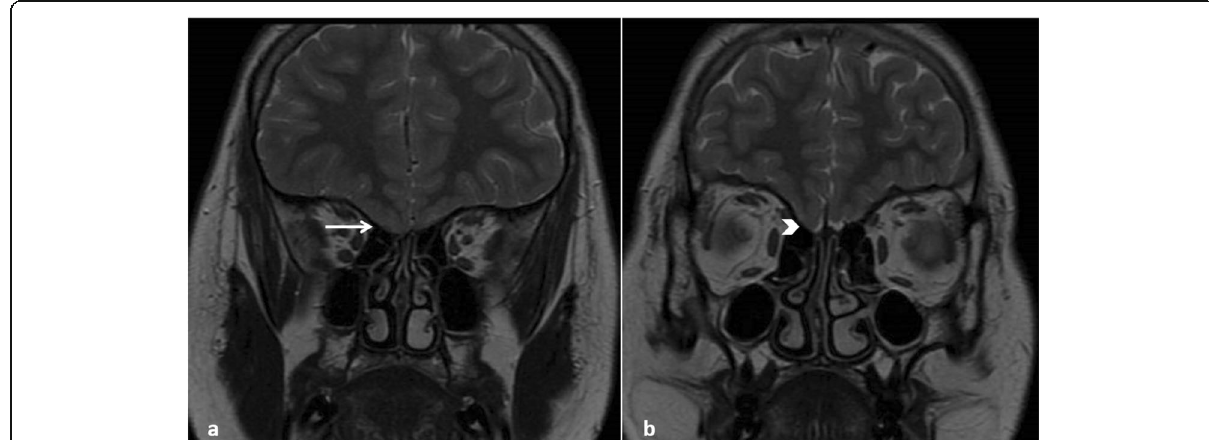
Fig. 1 a , b T2 weighted coronal MRI images of the brain through anterior cranial fossa showing hypoplastic olfactory sulcus (arrow in a ) with absence of olfactory bulbs in the olfactory grooves on both sides (arrow head in b )